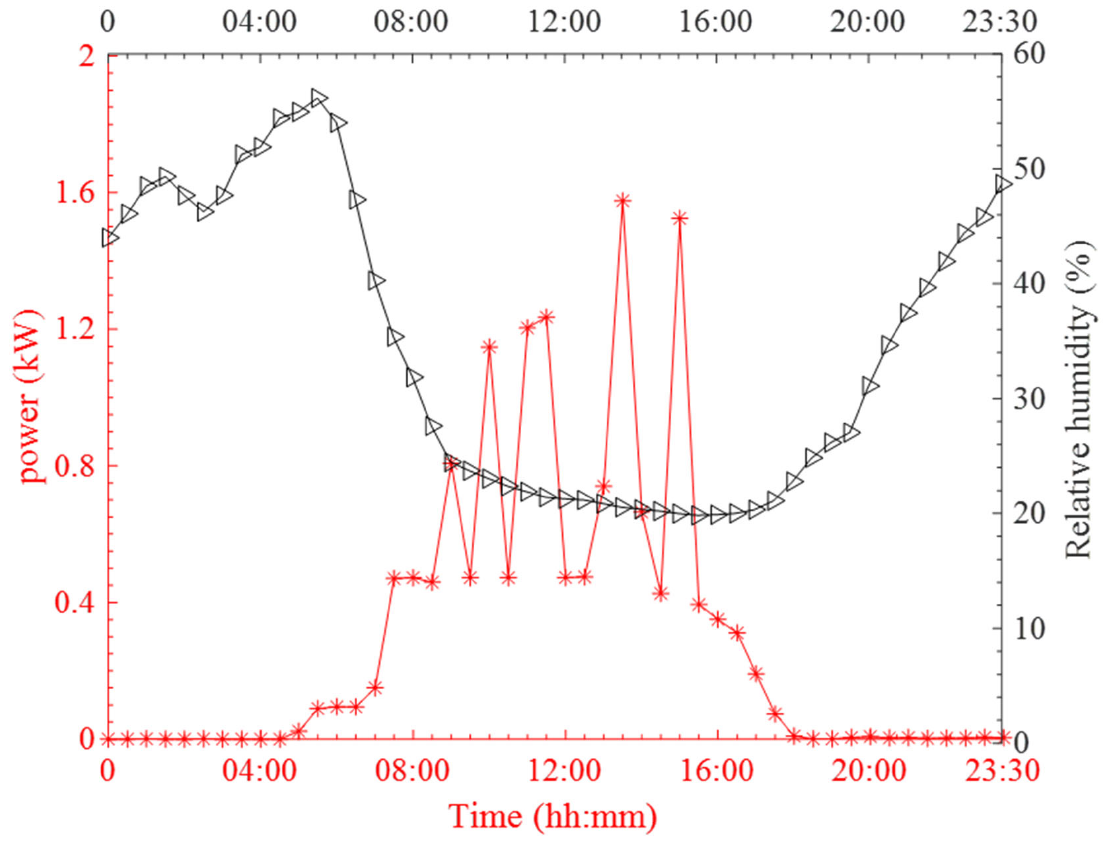
Figure 9. Average weekday profiles of power consumed and relative humidity. (kW denotes kilo Watt, % represents percentage, hh denotes hour and mm denotes minute).